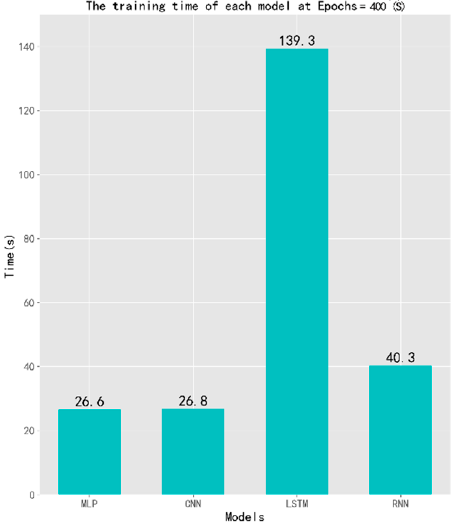
Figure 12. Loss values during training of four models.